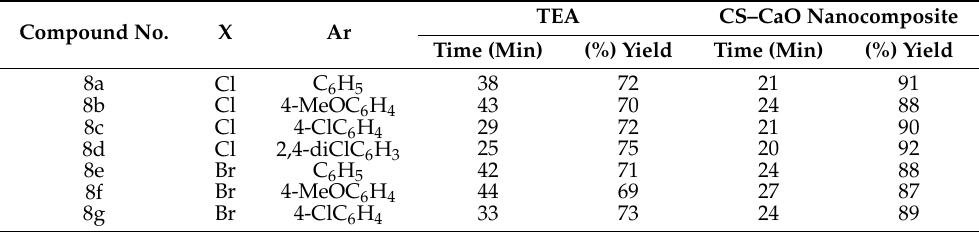
Table 1. The time of reaction and the yield % of the products compared in the synthesis of thiazoles 8a–g under ultrasonic irradiation utilizing two different basic catalysts. TEA CS–CaO Nanocomposite Compound No. X Ar Time (Min) (%) Yield Time